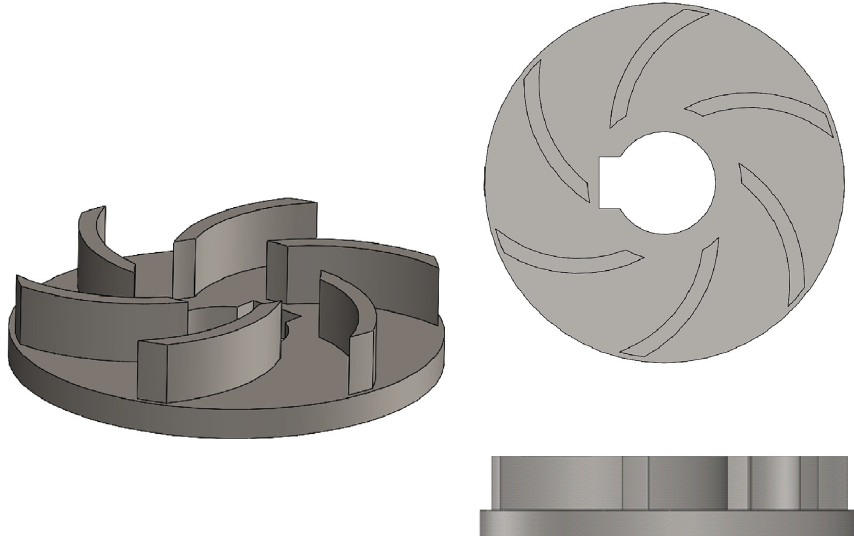
Figure 14: CAD model of the impeller.